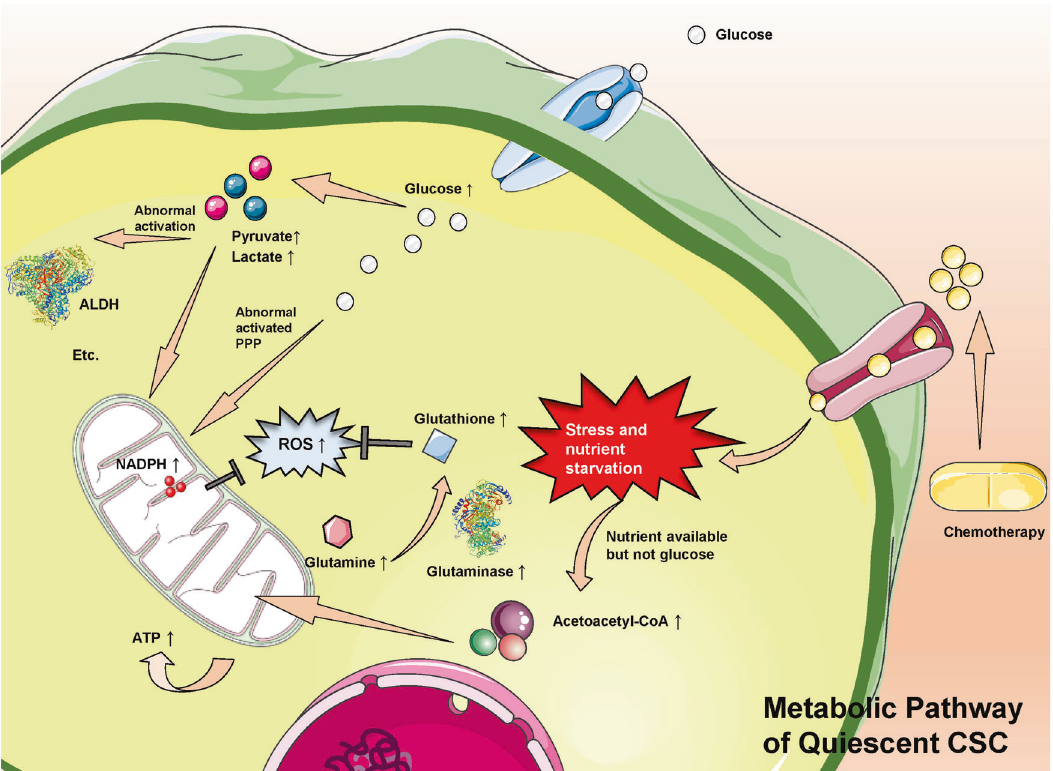
Fig. 2 Chemotherapy drugs are taken up by cancer cells, causing stress and nutrient starvation. Through the pentose phosphate pathway, glucose can indirectly produce NADPH, which confronts excessive intracellular ROS to maintain CSC in the quiescent state. Second, when nutrients in the TME are in short, nutrients excluding glucose are decomposed and go through OXPHOS to effectively produce ATP to sustain basic biological demand. Third, glutathione also can be synthesized from glutamine (an important and rich non-essential amino acid) and participate in the self-defense mechanism in response to excessive ROS and reduce its related adverse outcomes. Meanwhile, the intermediates in glycolysis, pyruvate, and lactate further can abnormally activate ALDH, initiating or strengthening CSC